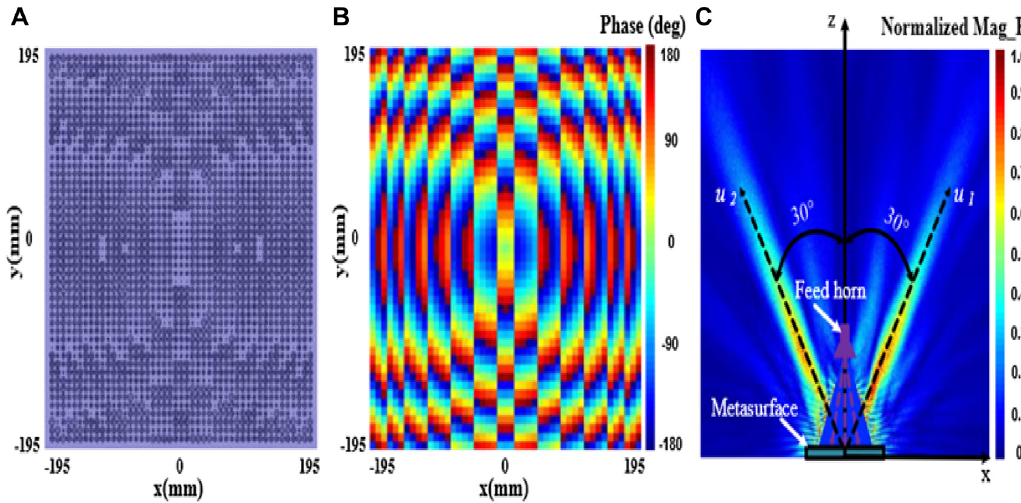
Figure 10: Non-diffractive beam metasurface. (A) Layout of the metasurface. (B) The compensation phase distribution of the designed metasurface. (C) The normalized E-field amplitude distribution of the dual pseudo-Bessel beams on the xoz-plane [78]. Reprinted from [78], with the permission of MDPI